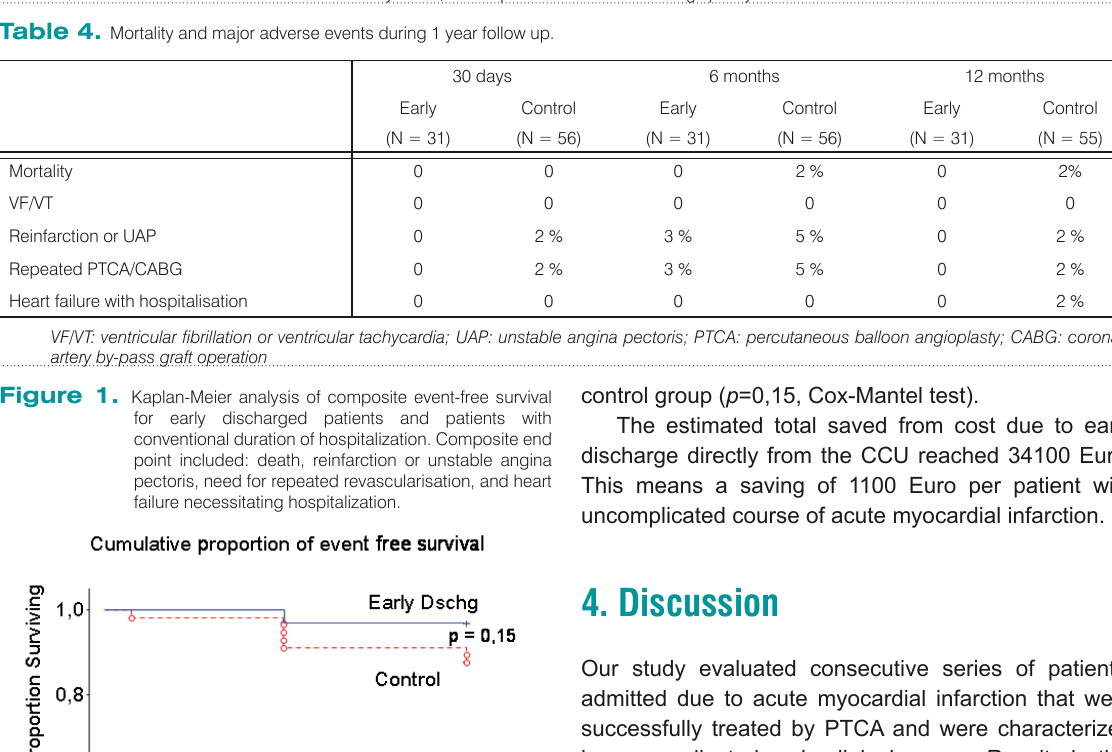
Table 4. Mortality and major adverse events during 1 year follow up.